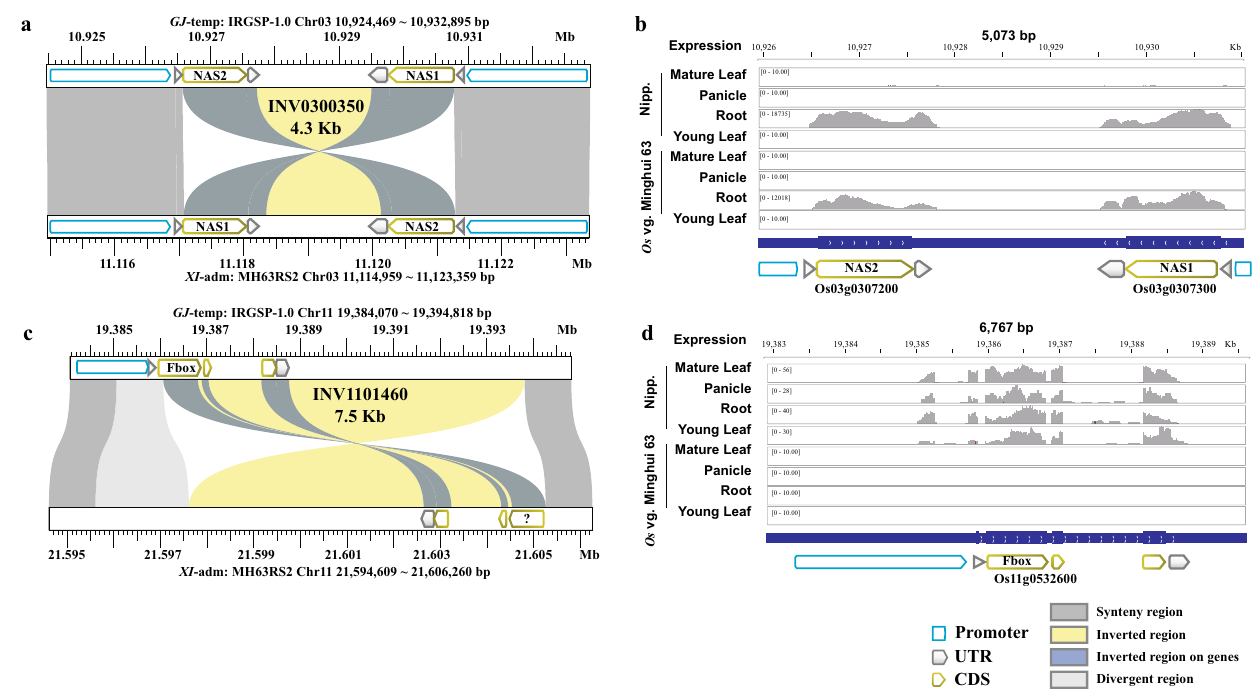
Fig. 6 | Transcriptabundanceofgenes locatedat inversion breakpoints. a Two copies of the OsNAS gene lie at the ends of an inversion in the MH63 ( XI -adm) genome. This inversion disrupted the 5 ’ UTR regions of two OsNAS genes ( NAS1 and NAS2 ); b OsNAS transcript abundance in root tissue; c The coding sequence